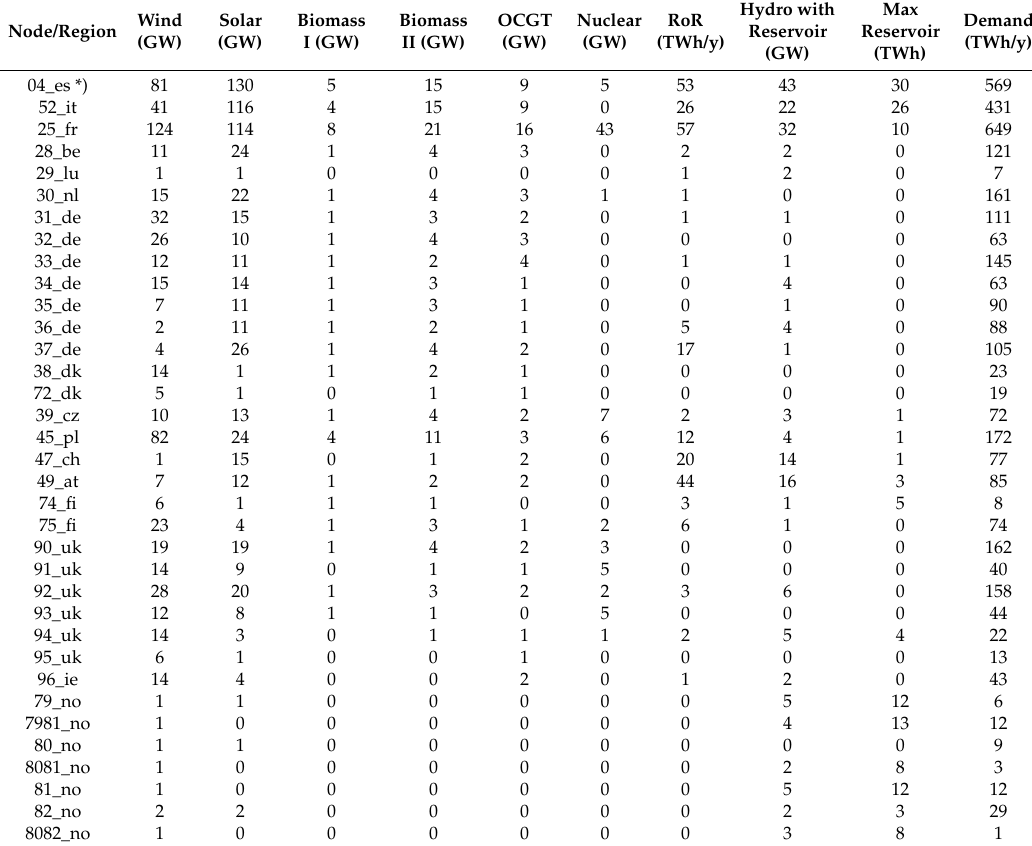
Table A1. Installed capacities and demand per node/region (see Figure 1) (from